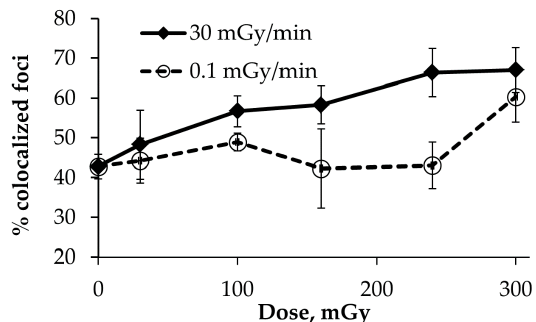
Figure 3. Percentage of γ H2AX foci co-localized with pATM foci in MSCs exposed either acutely or chronically to γ -radiation. The mean and SEM of three independent experiments are shown on the y -axis.